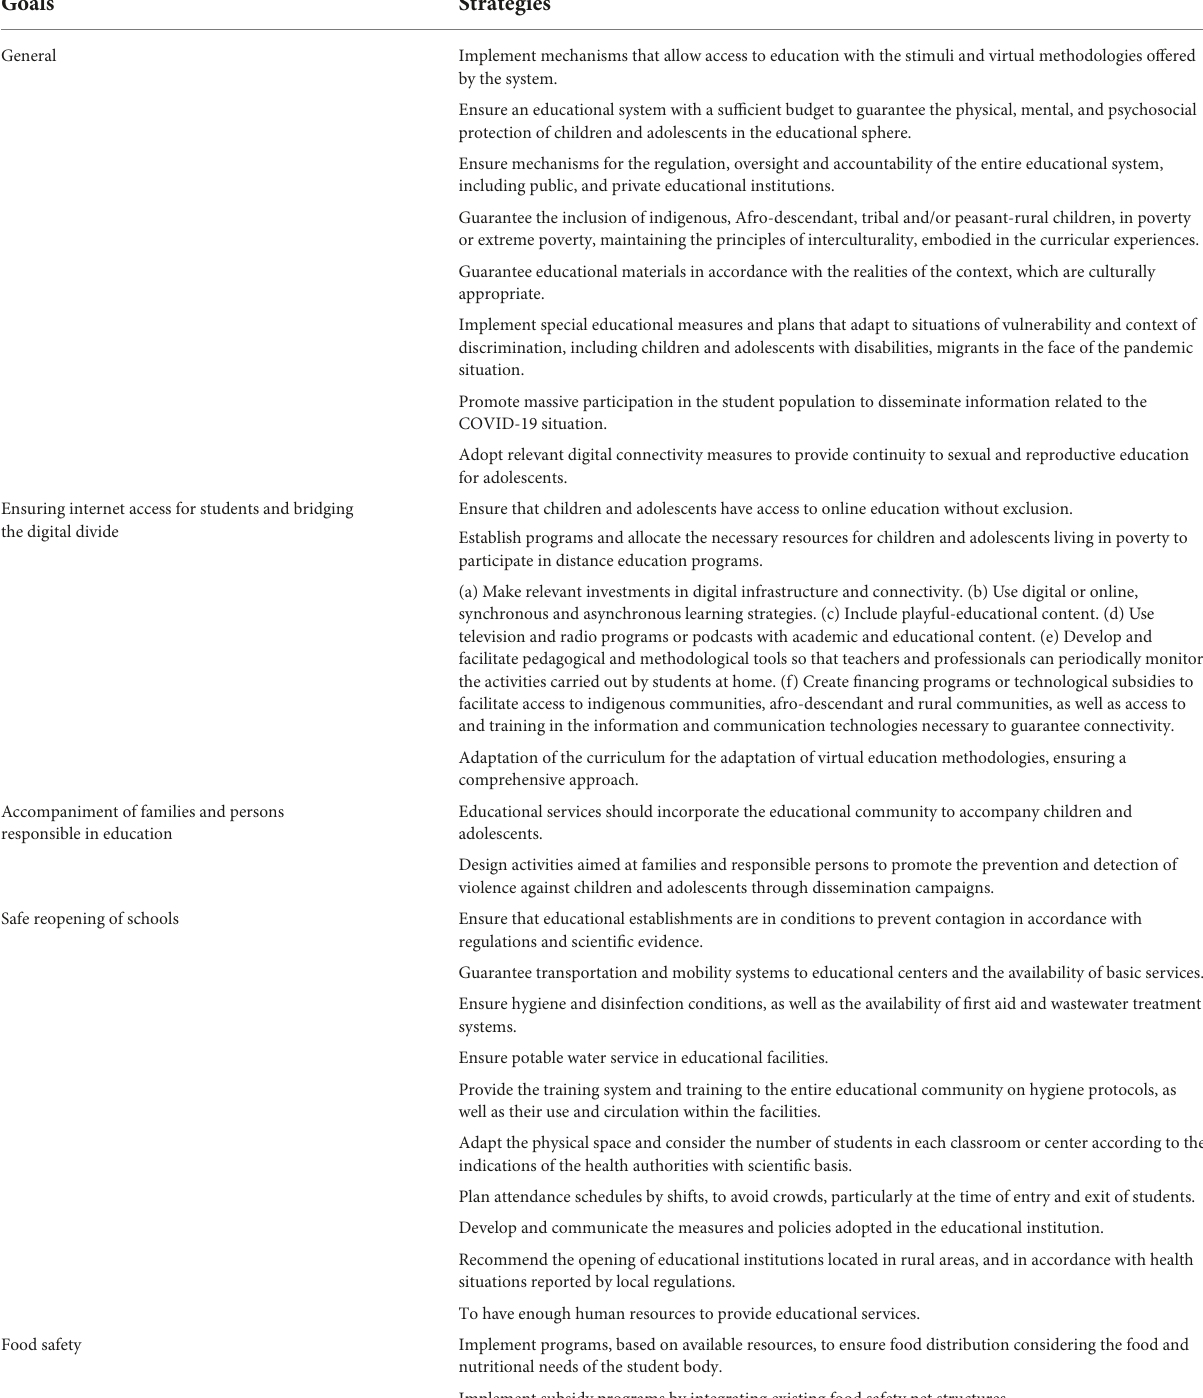
TABLE 3 Goals and strategies suggested by Organization of American States (OAS).